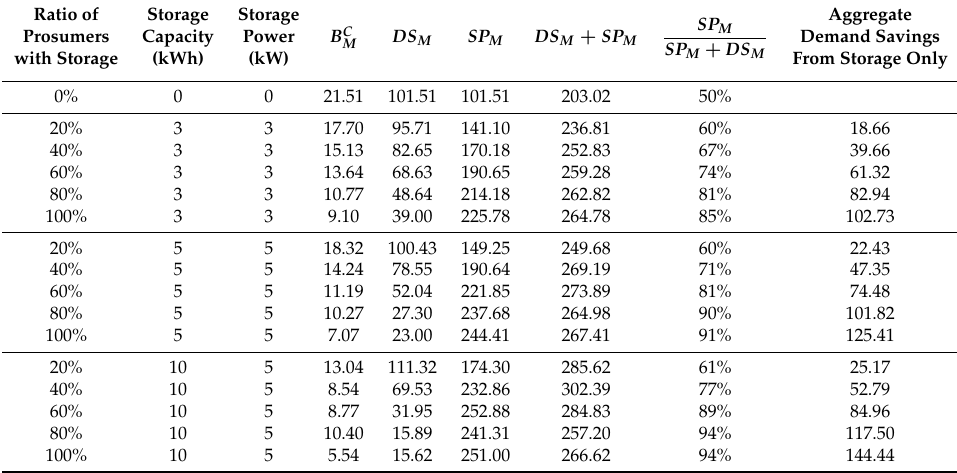
Figure 10. Comparison between the average daily DS K and SP K , and the average daily (cid:100) DS K and (cid:100) SP K for the setting with imperfect predictions without storage. The error bars represent 95% confidence intervals. ( a ) Average daily DS K and SP K . With 100% prosumer ratio, DS K is negative because of the uncapped bills approach. ( b ) Average daily (cid:100) DS K and (cid:100) SP K . The capped bills approach produces higher (cid:100) DS K and (cid:100) SP K compared to the uncapped DS K and SP K . Table 3. The results for M in £ for the setting with perfect predictions with storage. At the end of the period, B C is in a deficit state in all storage ratio variations. However, increasing the storage ratio M decreases the deficit. Also, increasing the storage ratio increases SP M as more prosumers become flexible, but, it also reduces DS M . By aggregating DS M and SP M , the configuration of 40% of prosumers having 10 kWh capacity storage devices, results in the most substantial combined benefit with 77% for SP M